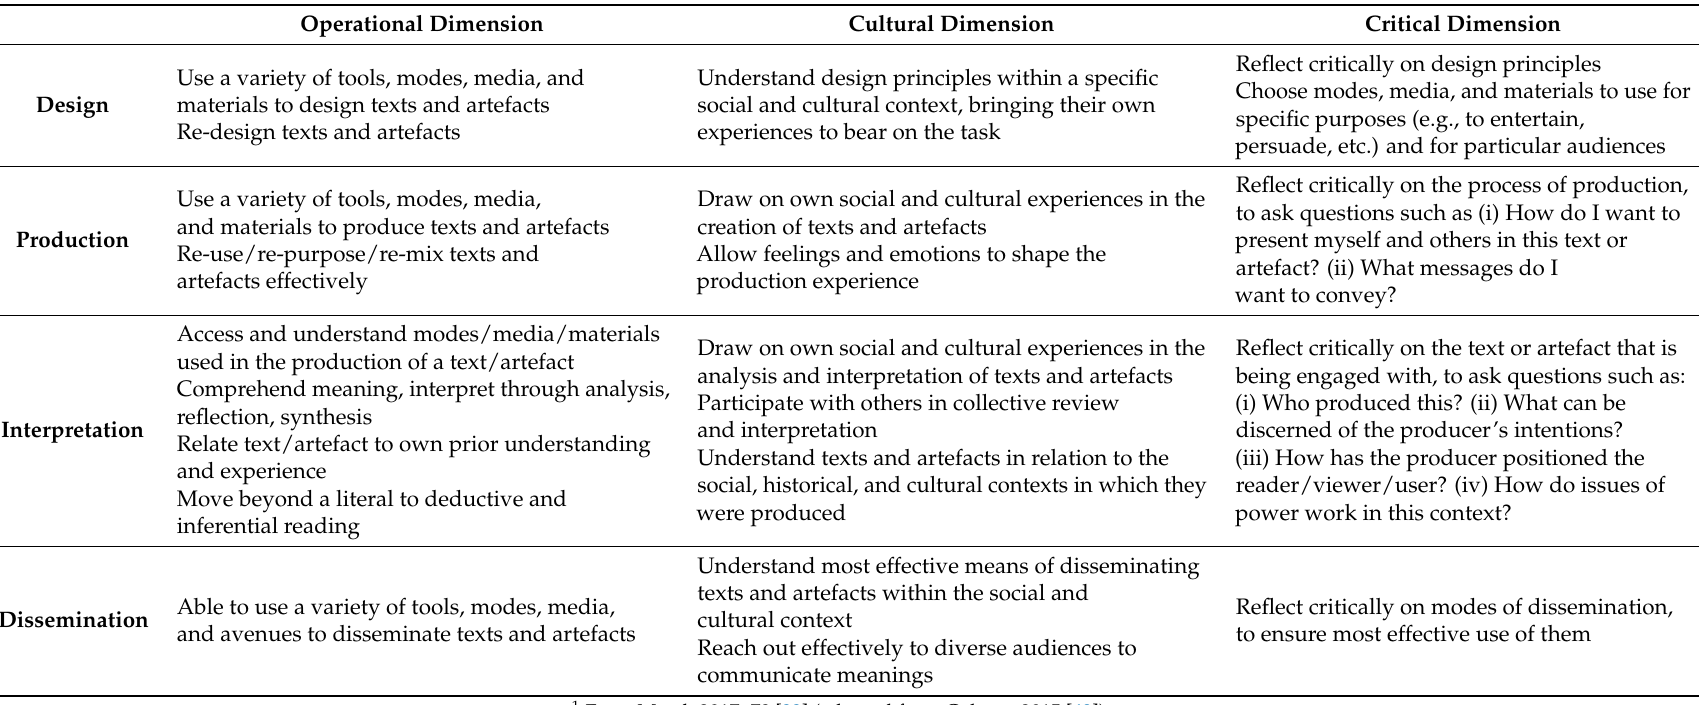
Table 1. Maker Literacies 1